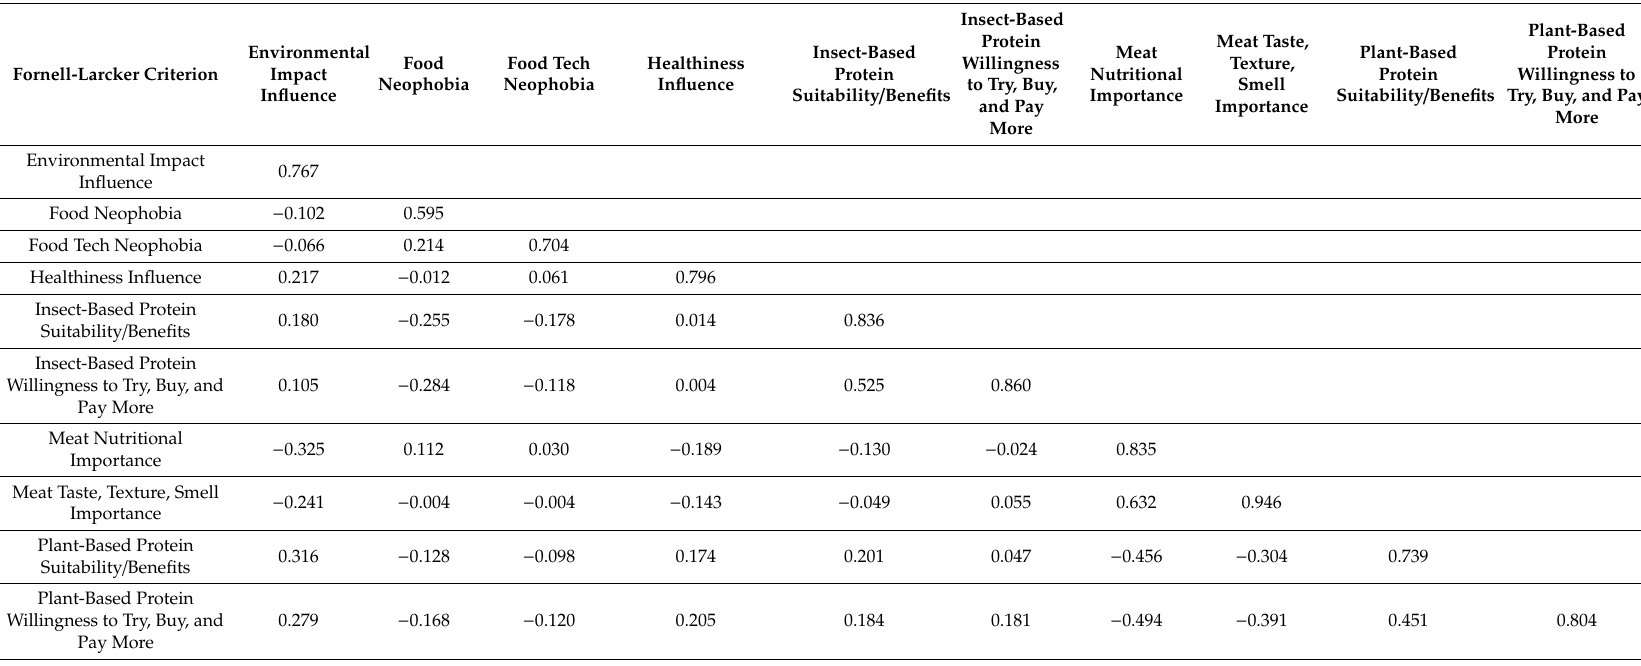
Table 3. Scale Discriminant